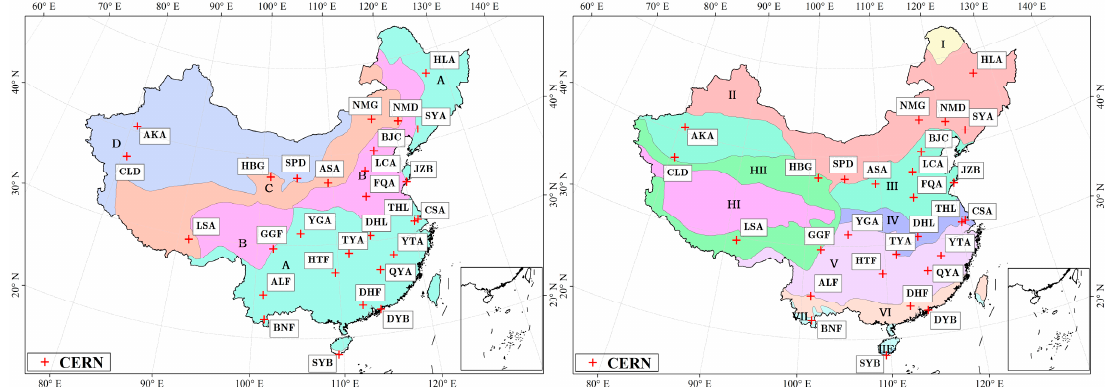
Figure A1. The humidity zones and temperate zones in China ( A —humid, B —semi-humid, C —semi-arid, D —arid; I —cold temperate, II —mid temperate, III —warm temperate, IV —north subtropical zone, V —the mid-subtropics, VI —the south subtropics, VII —the edge of tropical zone, HI —sub-frigid zone in plateau, HII —temperature zone in plateau, and IIE —mid tropical zone with humid weather).